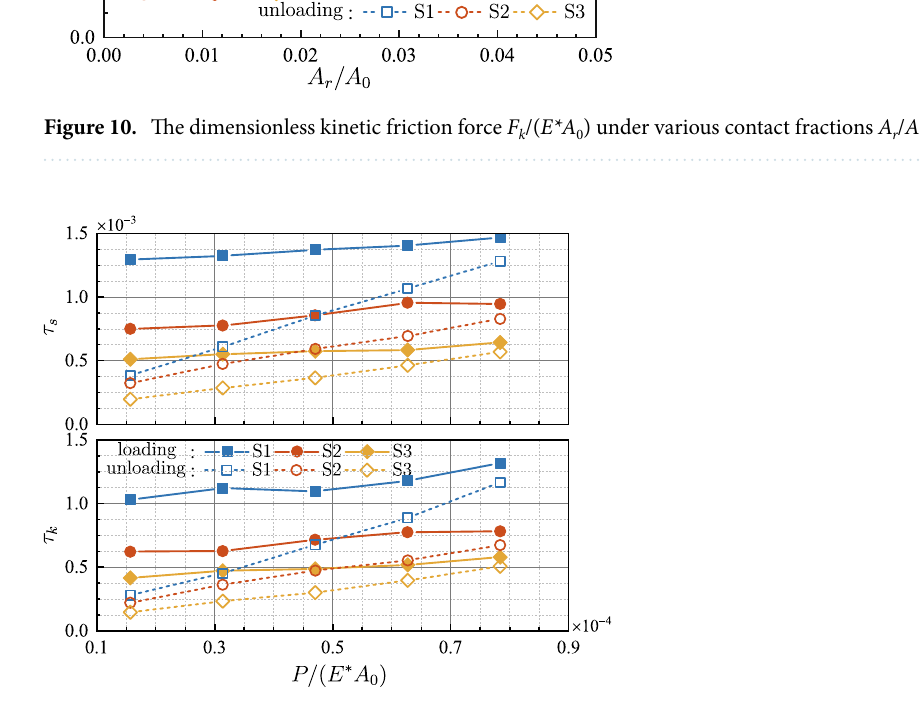
Figure 11. Evolution of the dimensionless mean tangential stress with respect to the dimensionless normal